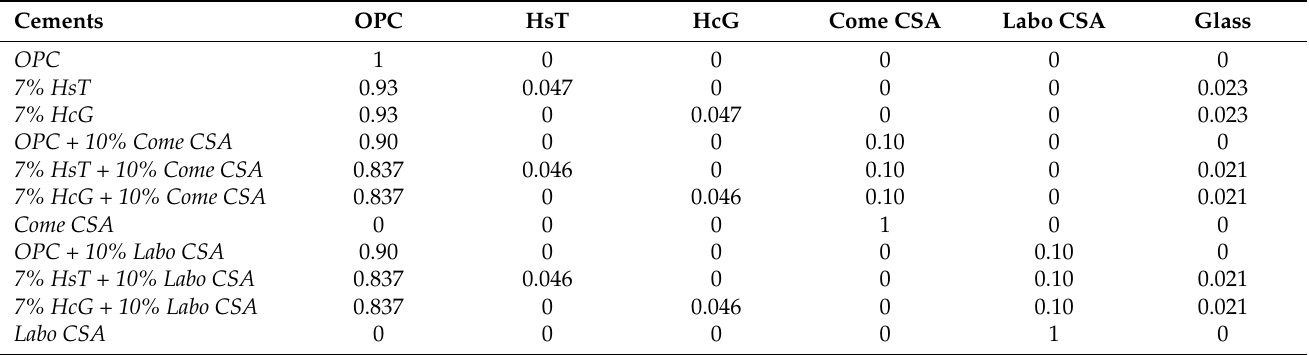
Table 4. Dosages of the different